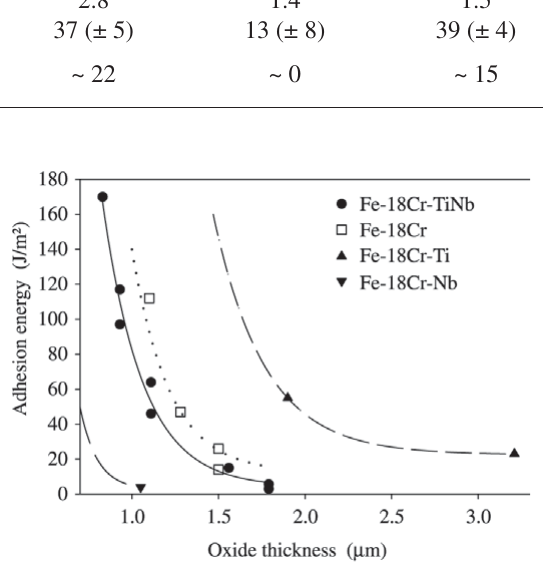
Figure 7. Isothermal oxidation at 900 °C in oxygen: adhesion en- ergy as a function of scale thickness.